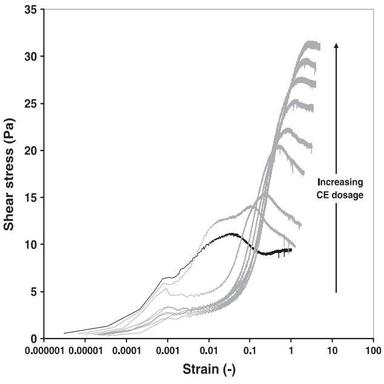
Flow onset measurements for the reference cement paste (black curve) and for pastes containing 0.1, 0.2, 0.4, 0.6, 0.8, 1.0, 1.2 and 1.5% of HEMC. Reproduced from with permission.